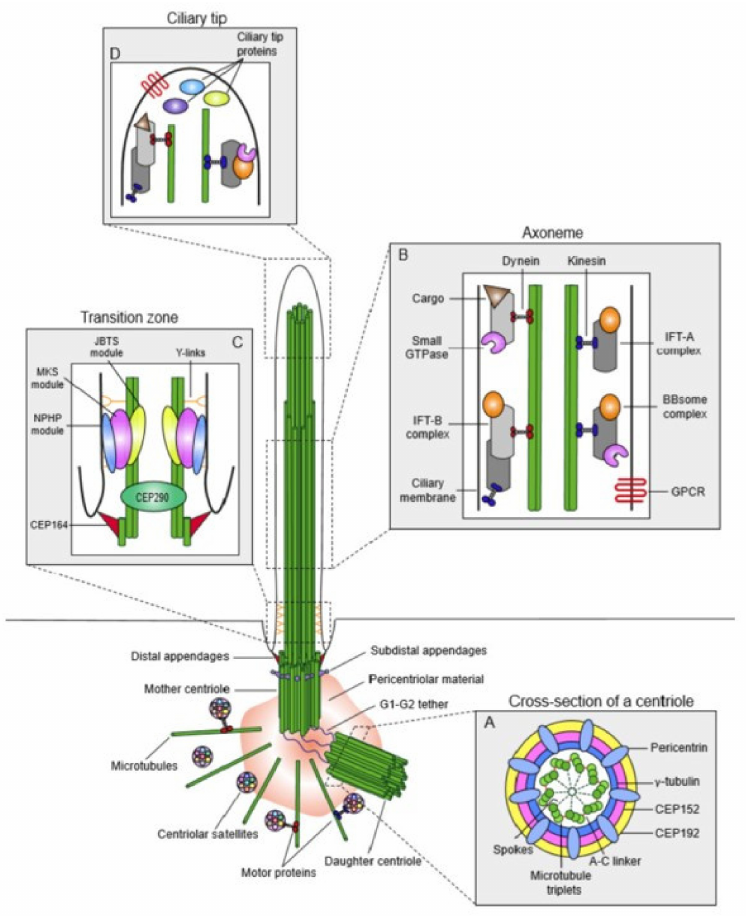
Figure 3. Overview of the anatomy of the centrosome/cilium complex and its sub-compartments. This complex is composed of three compartments, the centriole, the cilium, and the centriolar satellites. In primary cilia, the centrosome, consisting of two microtubule-organizing centers, recruits pericentriolar material (PCM). In Paramecium , these structures are not present, but instead each cilium is anchored by a basal body. In both, the centrioles (or basal bodies) differ in age where one is called the mother (the older) and the younger, called the daughter. The mother has distal appendages, and for primary cilia, the mother also acts as the basal body for cilium assembly. The primary cilium itself is compartmentalized into different regions, including the transition zone (TZ), the axoneme, and the ciliary tip. ( A ) A cross section of the proximal end of the centrioles containing nine triplets of microtubules symmetrically arranged in a ring connected by A–C linkers. These triplets are connected to the inner core of the centriole by radial spokes. The PCM material is organized into concentric layers and those layers are overlayed by a filamentous material, pericentrin. ( B ) The transition zone (TZ) has microtubule pairs, as the outmost microtubule does not extend the length of the cilium. This region acts as a barrier that regulates proteins into and out of the cilium through the NPHP-MKS-JBTS module. Transition fibers help to anchor the basal body to the ciliary membrane. ( C ) The ciliary axoneme is the core of the primary cilium and lacks a central pair of microtubules (that are present in motile cilia). These outer doublets of microtubules act as roadways for the IFT-A and IFT-B complexes, as well as the BBSome, to move cargo along the cilium. IFT-B and anterograde transport relies on kinesin-2 (blue) motors while retrograde transport and IFT-A rely on cytoplasmic dynein-2 (red) motors. The BBSome complex interacts with the IFT particles the move cargo into and out of the cilium. ( D ) The ciliary tip is a specialized region of primary cilia. Here, IFT particles, Hedgehog pathway components, and other microtubule-associated proteins work to regulate IFT remodeling, the length of the cilium, and Hedgehog signaling. Reproduced from [19], with permission through CC BY